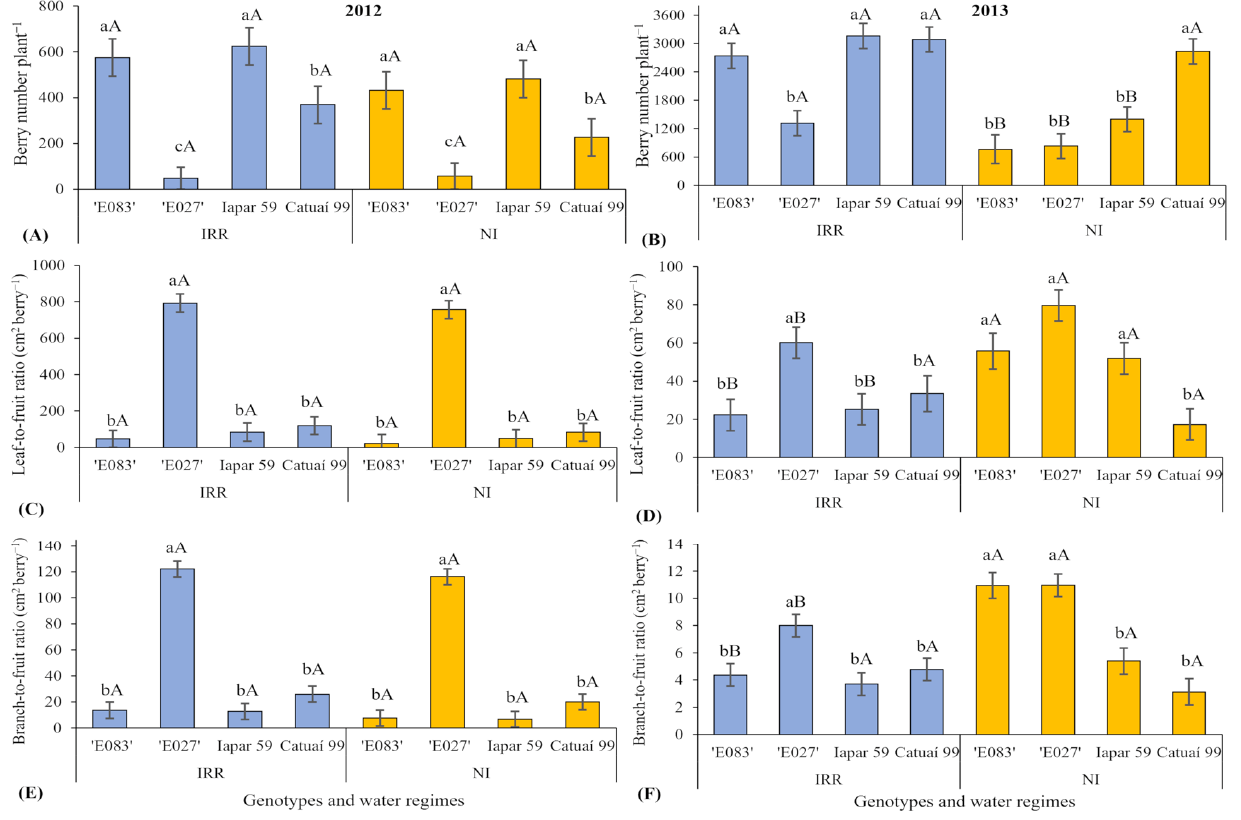
Figure 3. Reproductive and vegetative investments at plant scale: ( A ) Berry number in 2012 and ( B ) 2013; Leaf-to-fruit ratio (cm 2 berry − 1 ) in ( C ) 2012 and ( D ) 2013; Branch-to-fruit ratio (cm 2 berry − 1 ) in ( E ) 2012 and ( F ) 2013) of four genotypes of Coffea arabica cultivated under two water regimes (irrigated-IRR; not irrigated-NI). Mean values ± standard errors ( n = 4) are shown. Lower-case letters compare genotype effects within each water regime; upper-case letters compare water regime effects within each genotype, always separately for each harvest year.